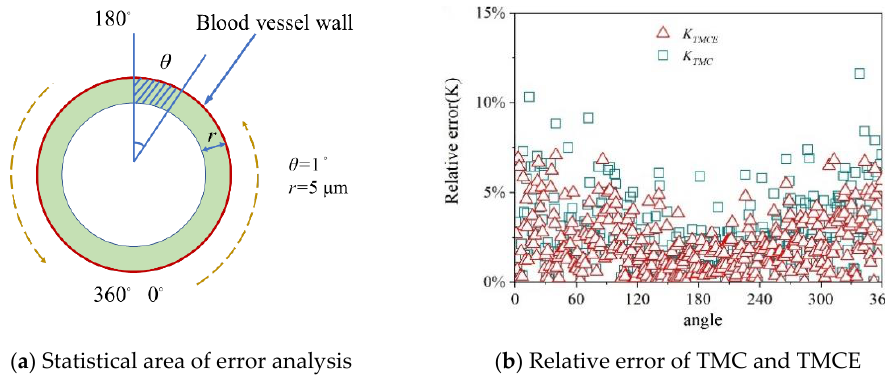
Figure 8. Relative error distribution in 1° annular cylinder region.